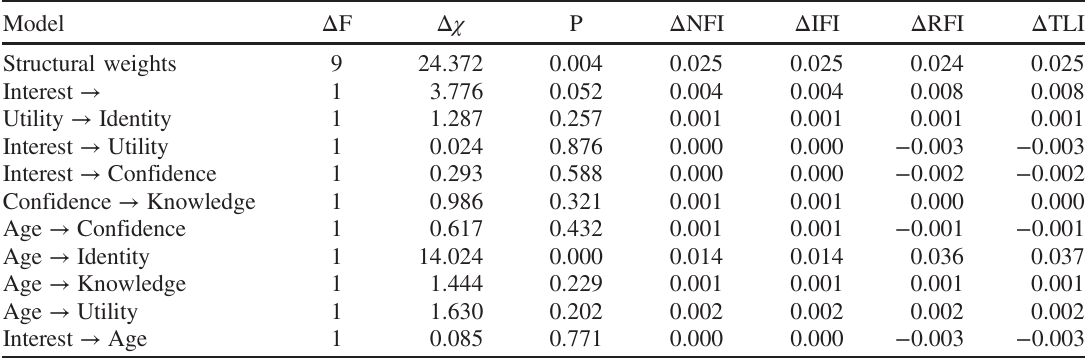
TABLE VI. Multigroup analysis for girls and boys for the model in Fig. 4. Model